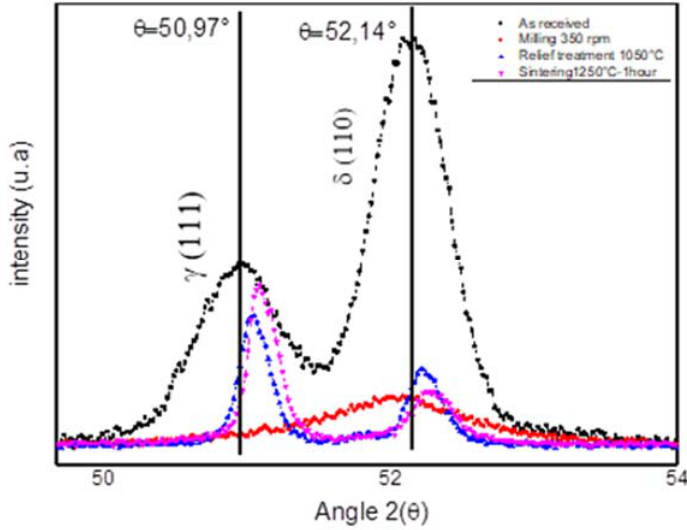
Figure 10. X ‐ ray diffraction spectrum extended between 50° and 54° after milling and also subjected Figure 10. X-ray diffraction spectrum extended between 50 ◦ and 54 ◦ after milling and also subjected to to stress relief and sintering treatment at 1250 °C for 1 h. stress relief and sintering treatment at 1250 ◦ C for 1